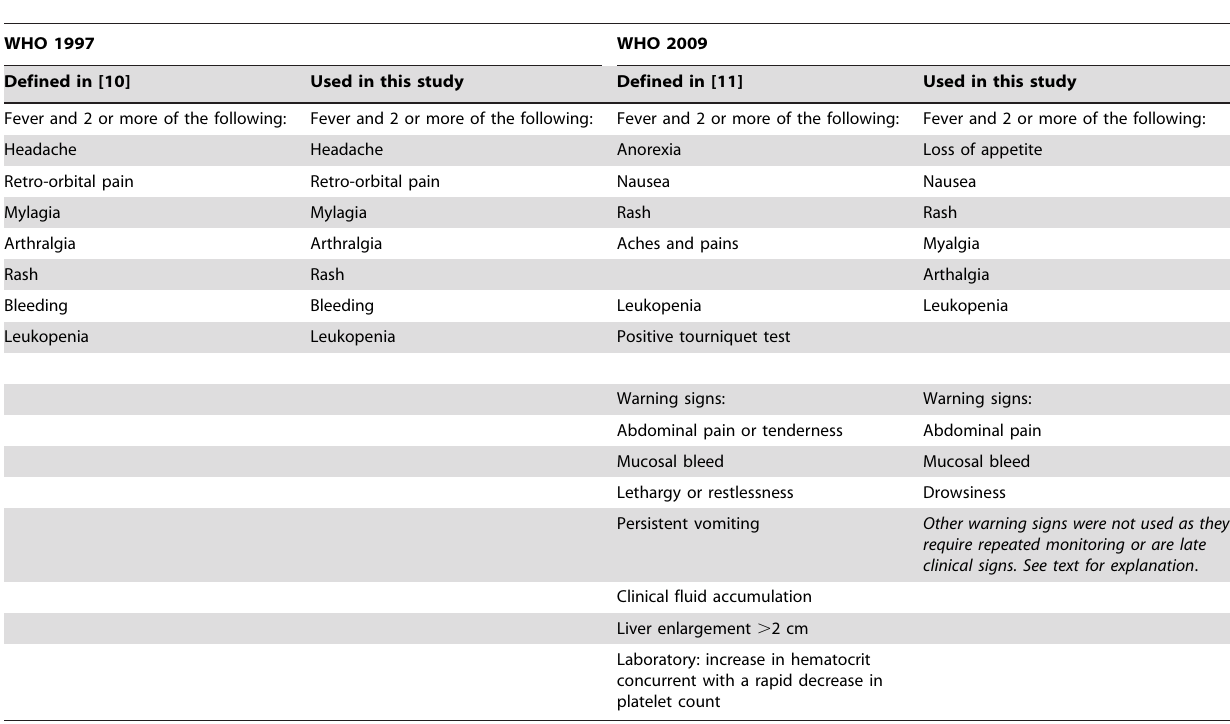
Table 1. The WHO 1997 and 2009 classification schemes and the parameters used in this study.